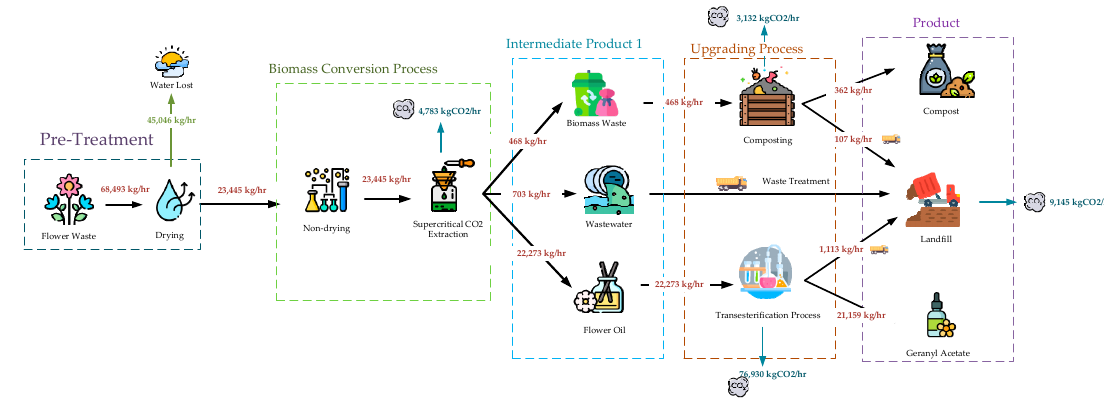
Figure 3. Optimisation based on maximum economic potential—scenario 1.